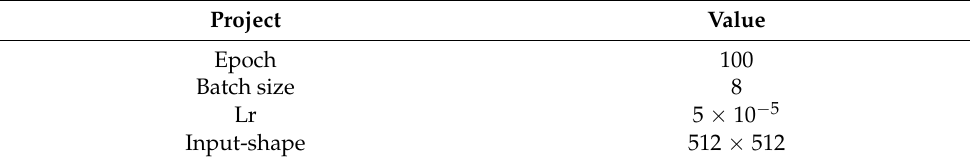
Figure 7. Loss function diagram of standing tree segmentation. Table 4. The hyper-parameters.